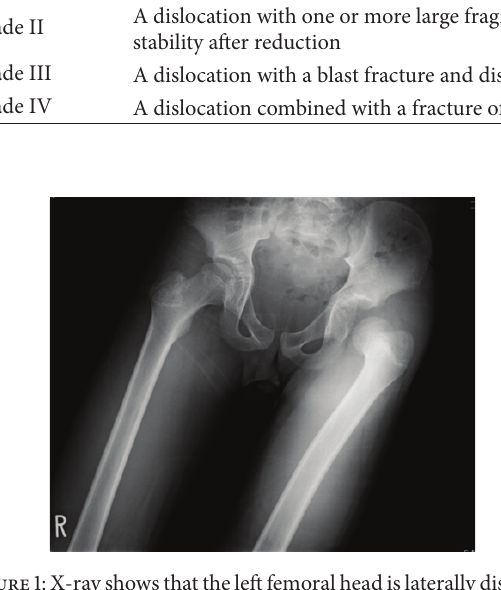
Figure 1: X-ray shows that the left femoral head is laterally displaced to the acetabulum, which is consistent with posterior dislocation of the hip.